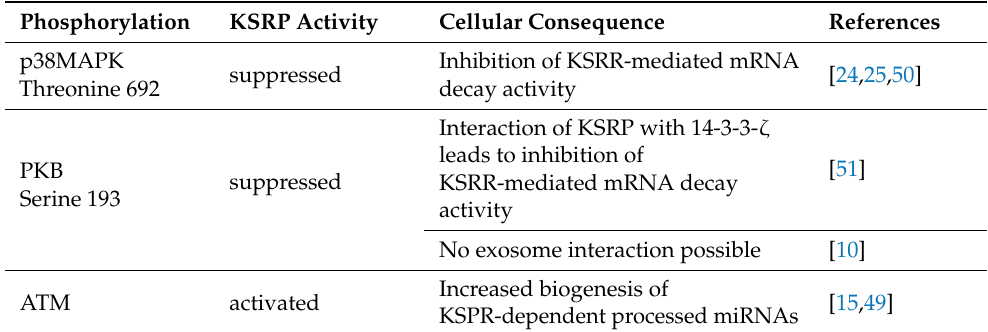
Table 3. Modification of KSRP by phosphorylation.